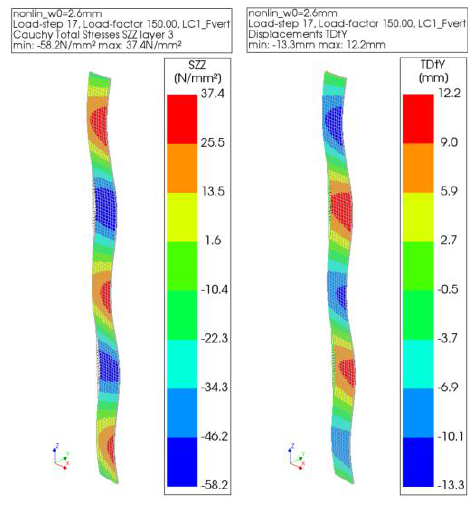
Fig. 8 Stress and displacement results from geometric nonlinear structural analysis.